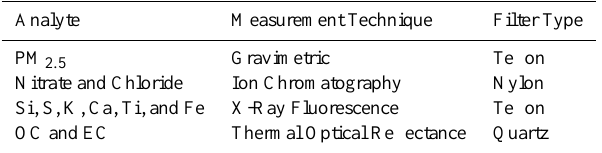
Table 1. Summary of measurement techniques and filter types for each PM component included in the regression analyses. For details, see Malm et al. (2004) and the IMPROVE data guide (http://vista.cira.colostate.edu/improve/Publications/OtherDocs/